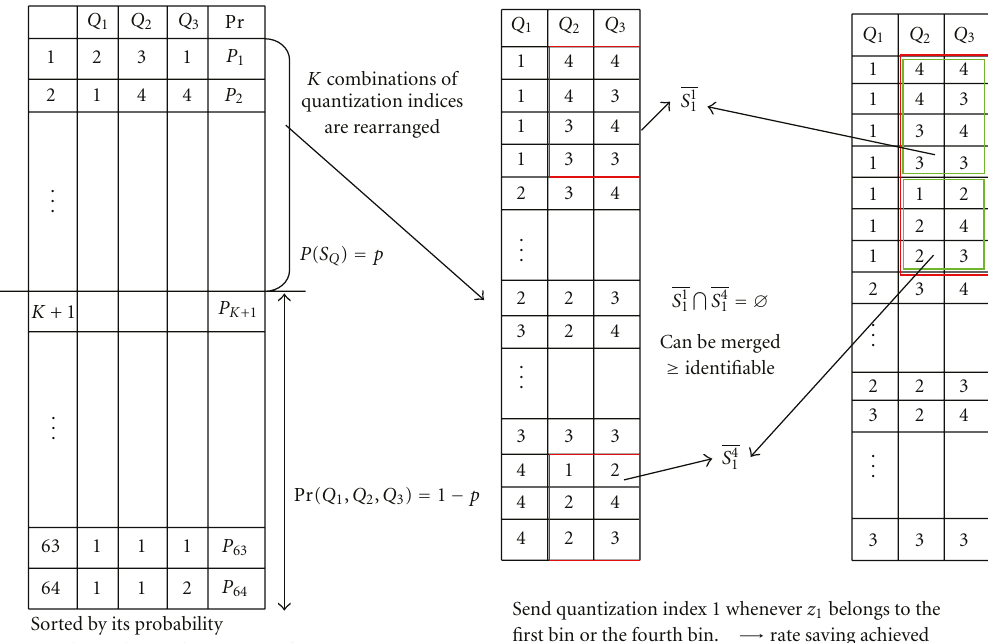
Figure 3: Simple example of merging process, where there are 3 nodes and each node uses a 2 bit quantizer ( Q i ∈ { 1,2,3,4 } ). In this case, it is assumed that Pr( S M − S Q ) = 1 − p ≈ 0